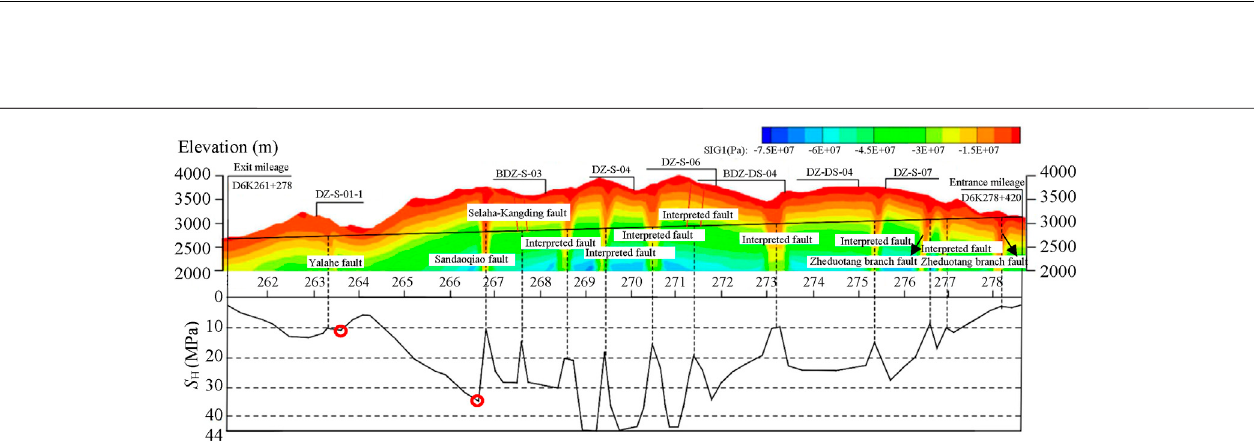
FIGURE 9 | The contour map and line chart of the maximum horizontal principal stress of a tunnel.